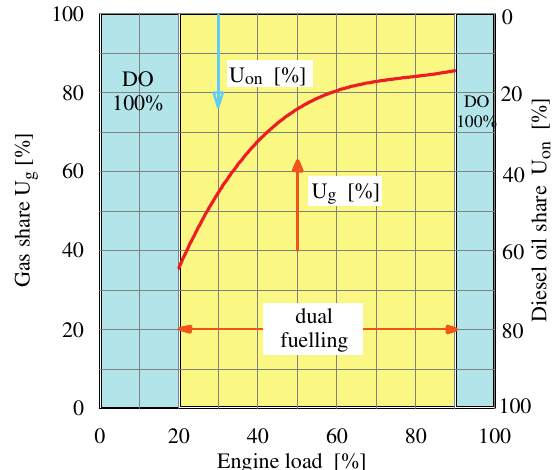
Fig. 4. Proposed range of gaseous fueling in dual fuel traction engine [18] Dual fuel feeding advantageously affects engine effi- ciency in range of maximal loads, when the engine is run on rich gaseous mixture. Composition of gaseous mixture depends on size of initial dose, while maintaining the same M = M engine load, the gaseous mixture undergoes oDO oDF enrichment as the initial dose decreases. In the tested en- gine of SB3.1 type for the dose of q = 14.6 mm 3 /cycle at maximal engine load, overall efficiency increased in com- plete range of change of engine speed, Fig. 5a. Absolute growth of the efficiency has amounted to 0.9–2.1%, de- pending on engine speed.